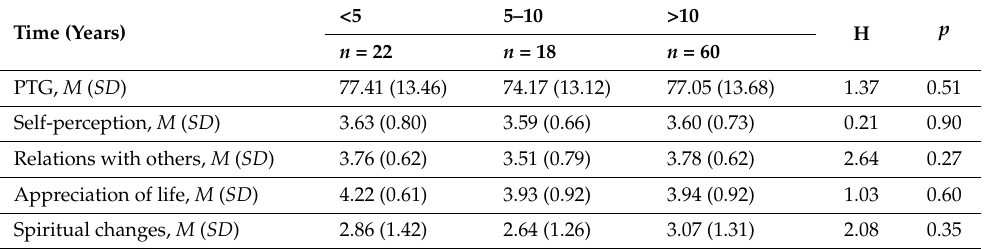
Table 5. Differences in post-traumatic growth and its components in women with illnesses of different durations (Kruskal–Wallis test).